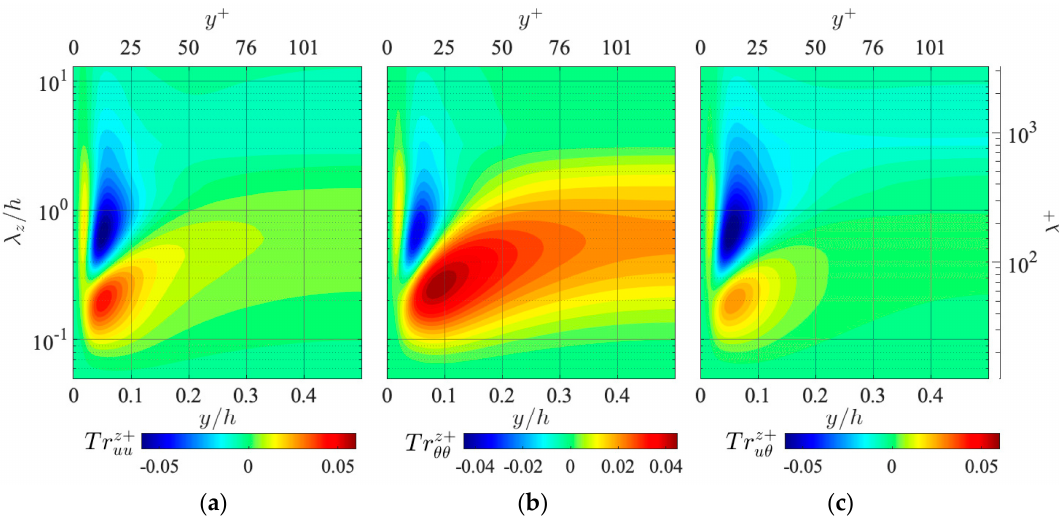
Figure 5. Space-wavelength ( y − λ z ) diagrams of spanwise interscale fluxes of ( a ) the turbulent kinetic energy Tr z uu , ( b ) temperature fluctuation Tr z The values are scaled by u 4 τ / ν , u 2 τ , T 2 τ / ν , and u 3 τ T τ / ν , respectively.